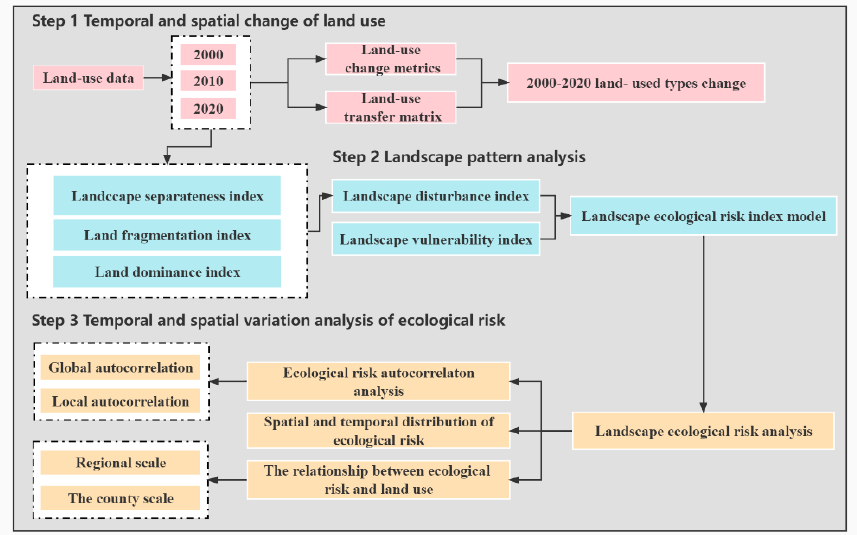
Figure 3. The framework of this study.